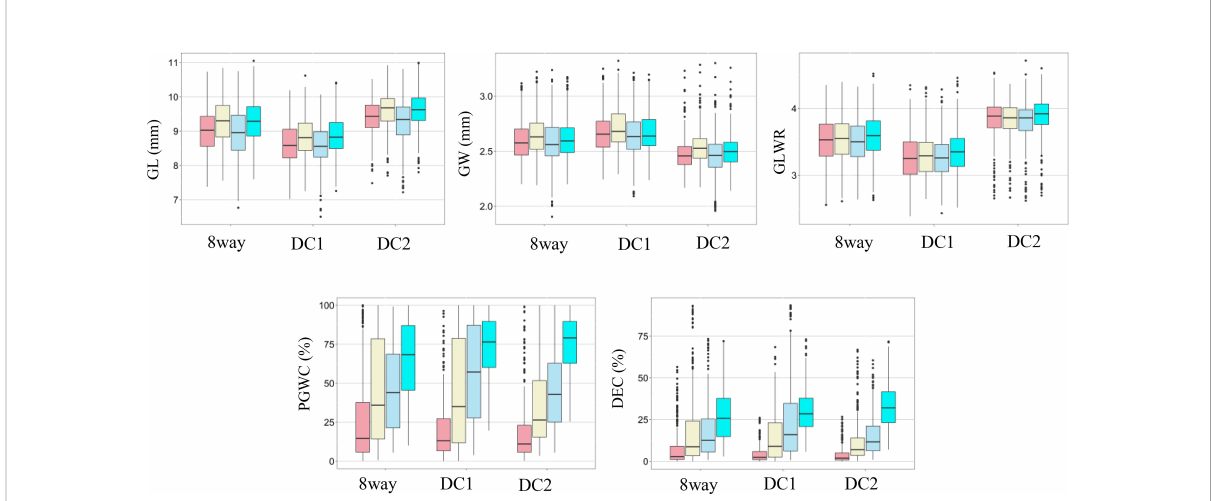
FIGURE 1 Box plots of fi ve rice grain shape and appearance quality traits in two environments and years. GL, Grain length; GW, Grain width; GLWR, Grain length to width ratio; DEC, Degree of endosperm chalkiness; PGWC, Percentage of grains with chalkiness. Light pink, light yellow, light blue and cyan colors indicate 2015 in PX, 2015 in SZ, 2016 in PX and 2016 in SZ,